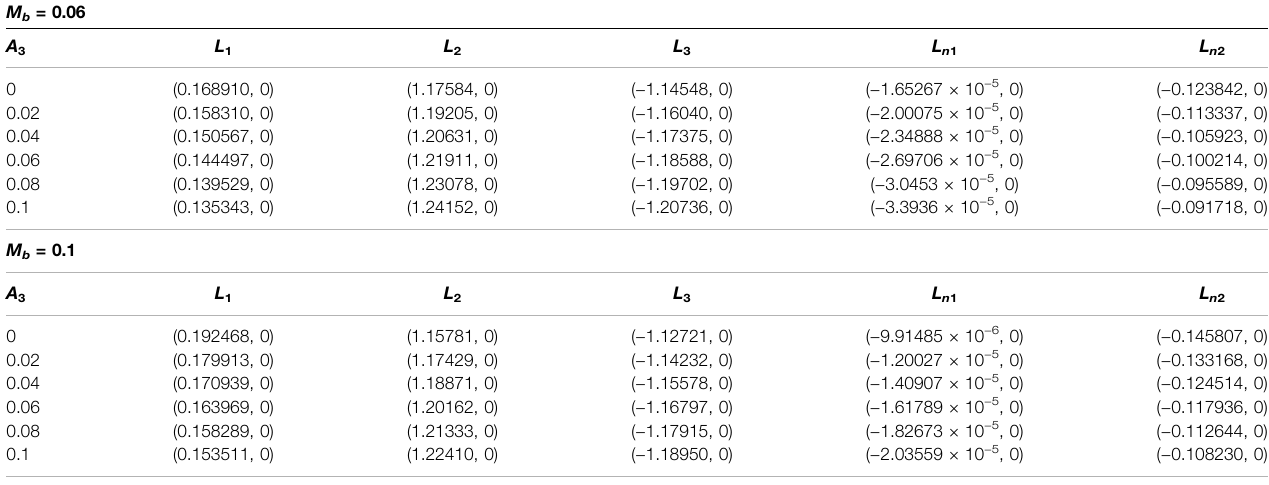
b when the value of A 3